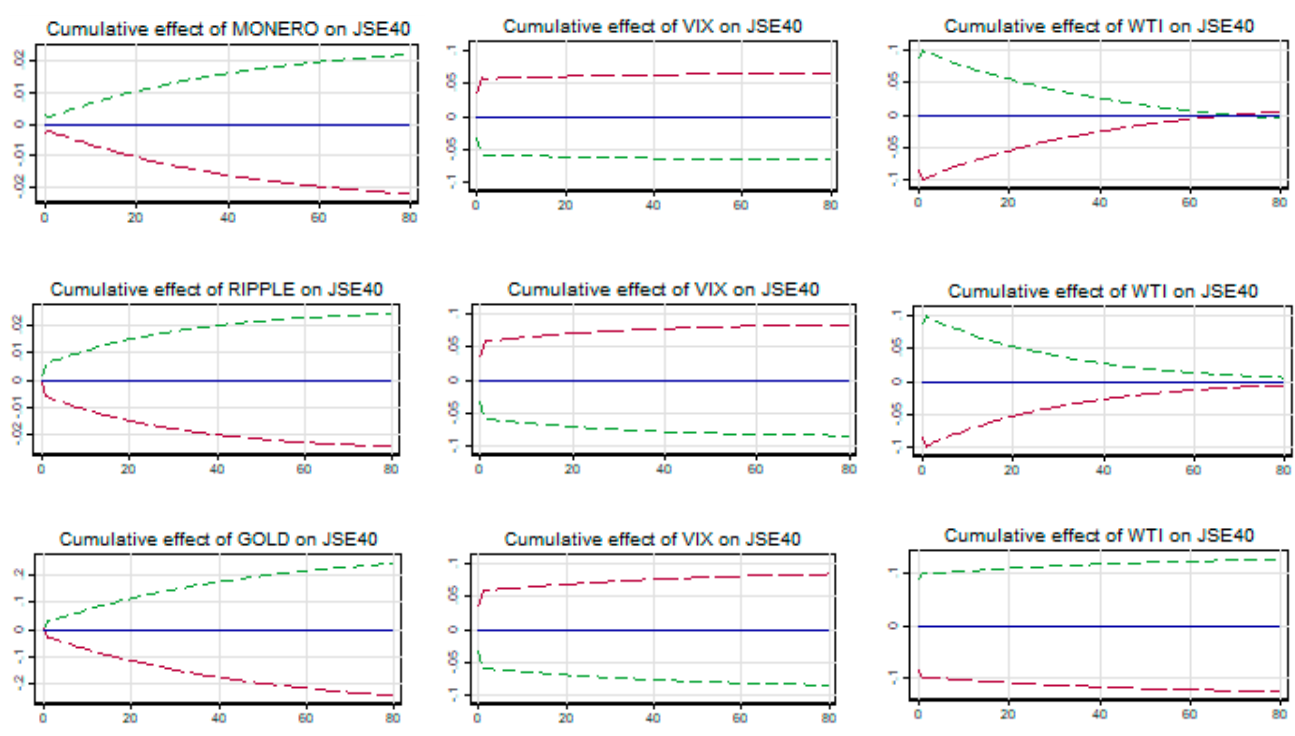
Figure 3. Cumulative effects of cryptos and gold on JSE40.